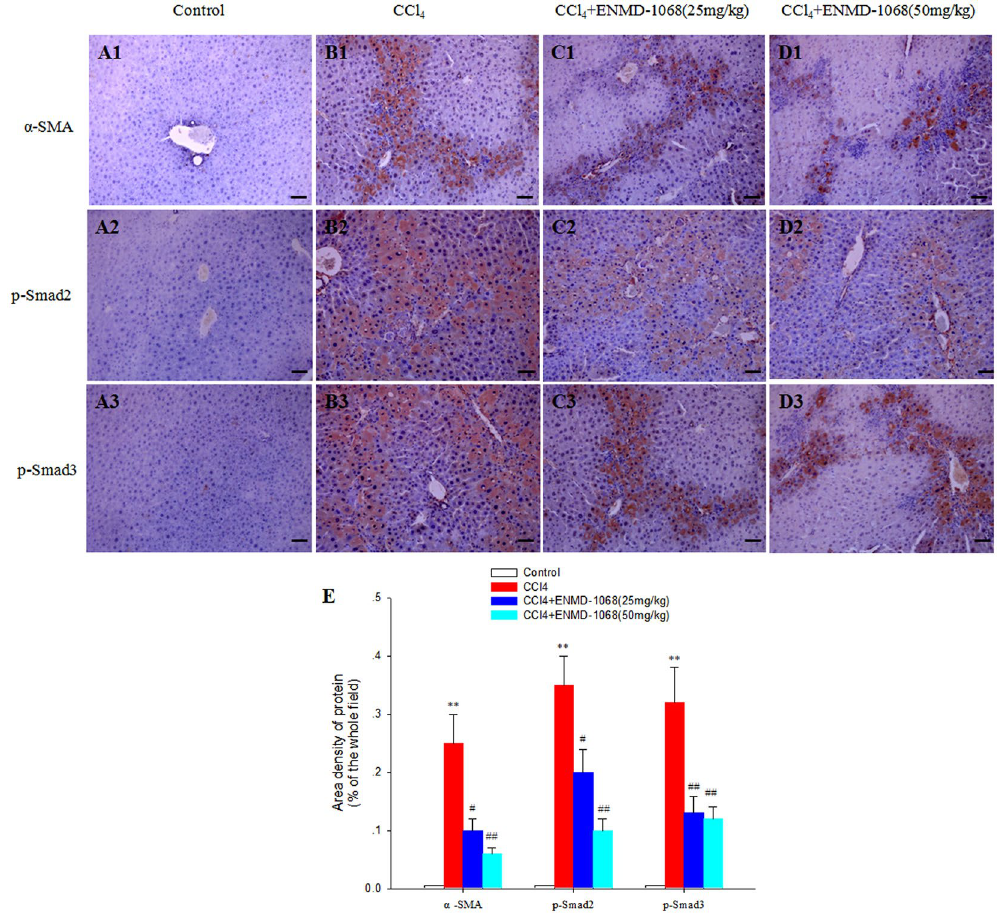
Figure 5. Effect of ENMD-1068 on α -SMA and p-Smad2/3 expression in liver sections. α -SMA and p-Smad2/3 immunohistochemistry were performed to measure effect of ENMD-1068 on HSCs activation in liver sections in ( A1–3 ) Control, ( B1–3 ) CCl 4 , ( C1–3 ) CCl 4 + ENMD-1068 (25 mg/kg) and ( D1–3 ) CCl 4 + ENMD-1068 (50 mg/kg) mice. ( E ) Relative to CCl 4 treatment, ENMD-1068 treatment at both 25 and 50 mg/kg reduced significantly the expression of α -SMA and p-Smad2/3. N = 6, bars represent SD, ** P < 0.01 vs